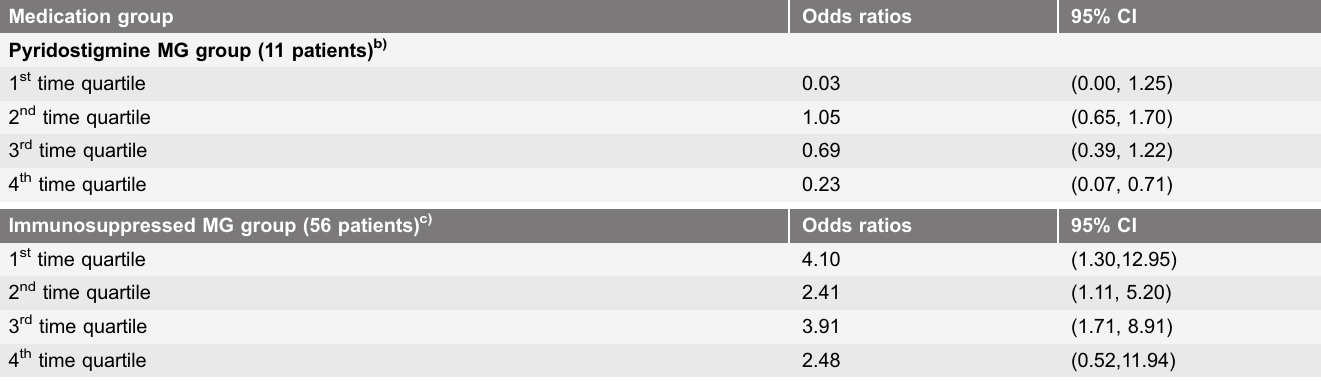
Abbreviations: AChR: Acetylcholine receptor; MGFA: Myasthenia gravis Foundation of America (1–5); MG: Myasthenia gravis; CI: Confidence interval. a)Odds ratio per 100 nmol/L. b)Patients treated with pyridostigmine only. c)Patients treated with immunosuppressive